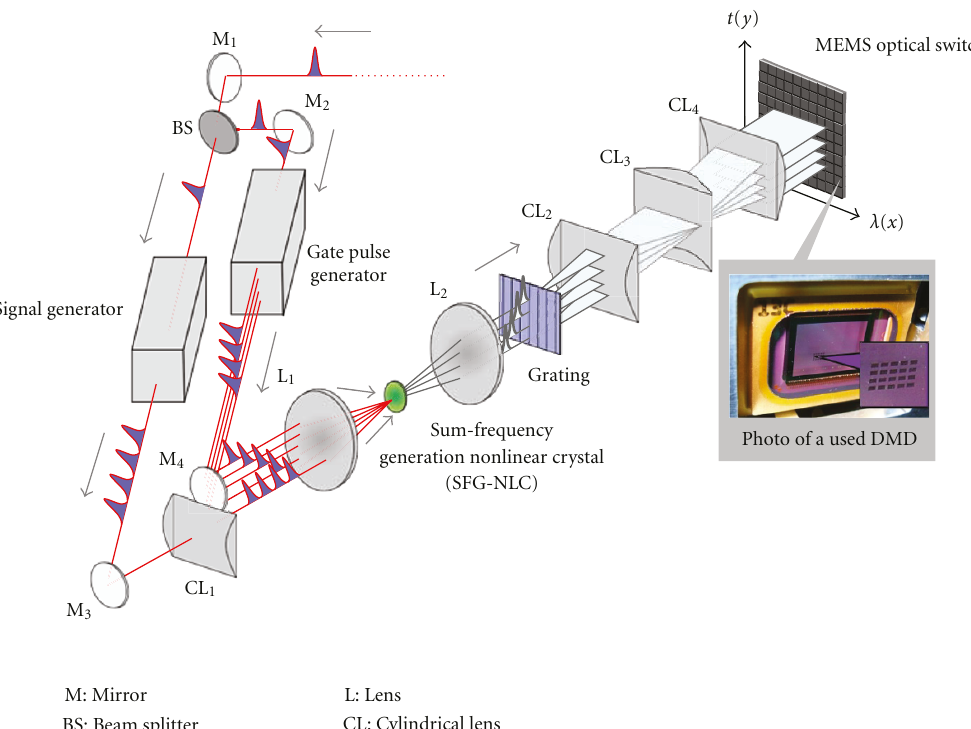
Figure 2: Experimental setup for the proposed